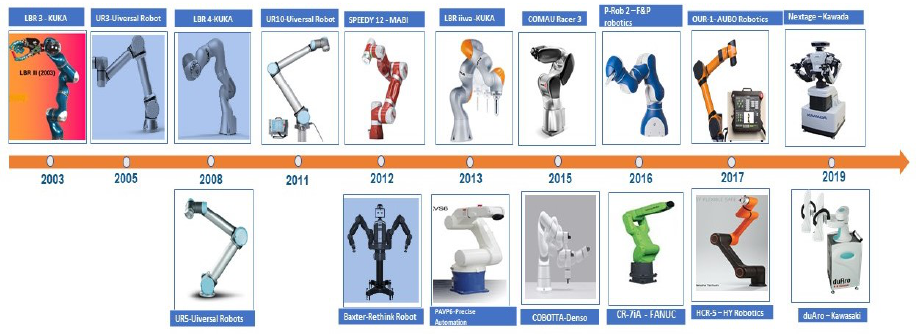
Figure 1. Development of collaborative robotic